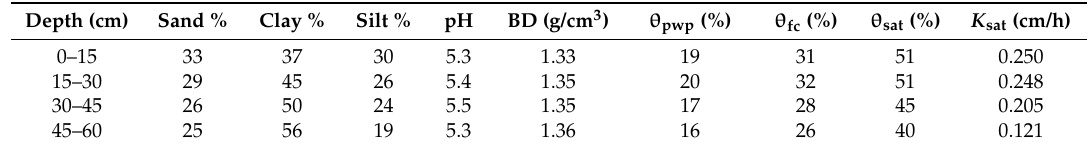
Table 2. Soil properties of the study